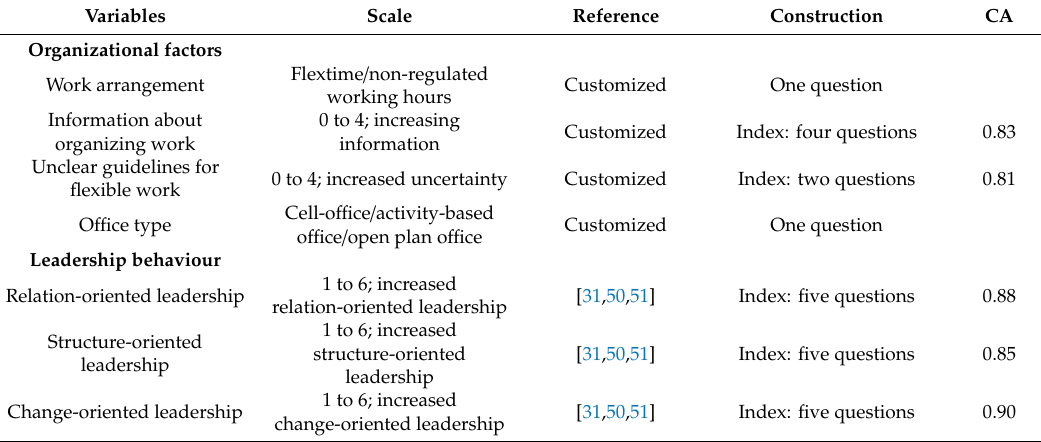
Table 1. All independent variables, showing variable name, scale (range and direction of the scale), references to prior studies using the variable (if applicable), construction of the variable (i.e., index or single question), and Cronbach alpha (CA) of the